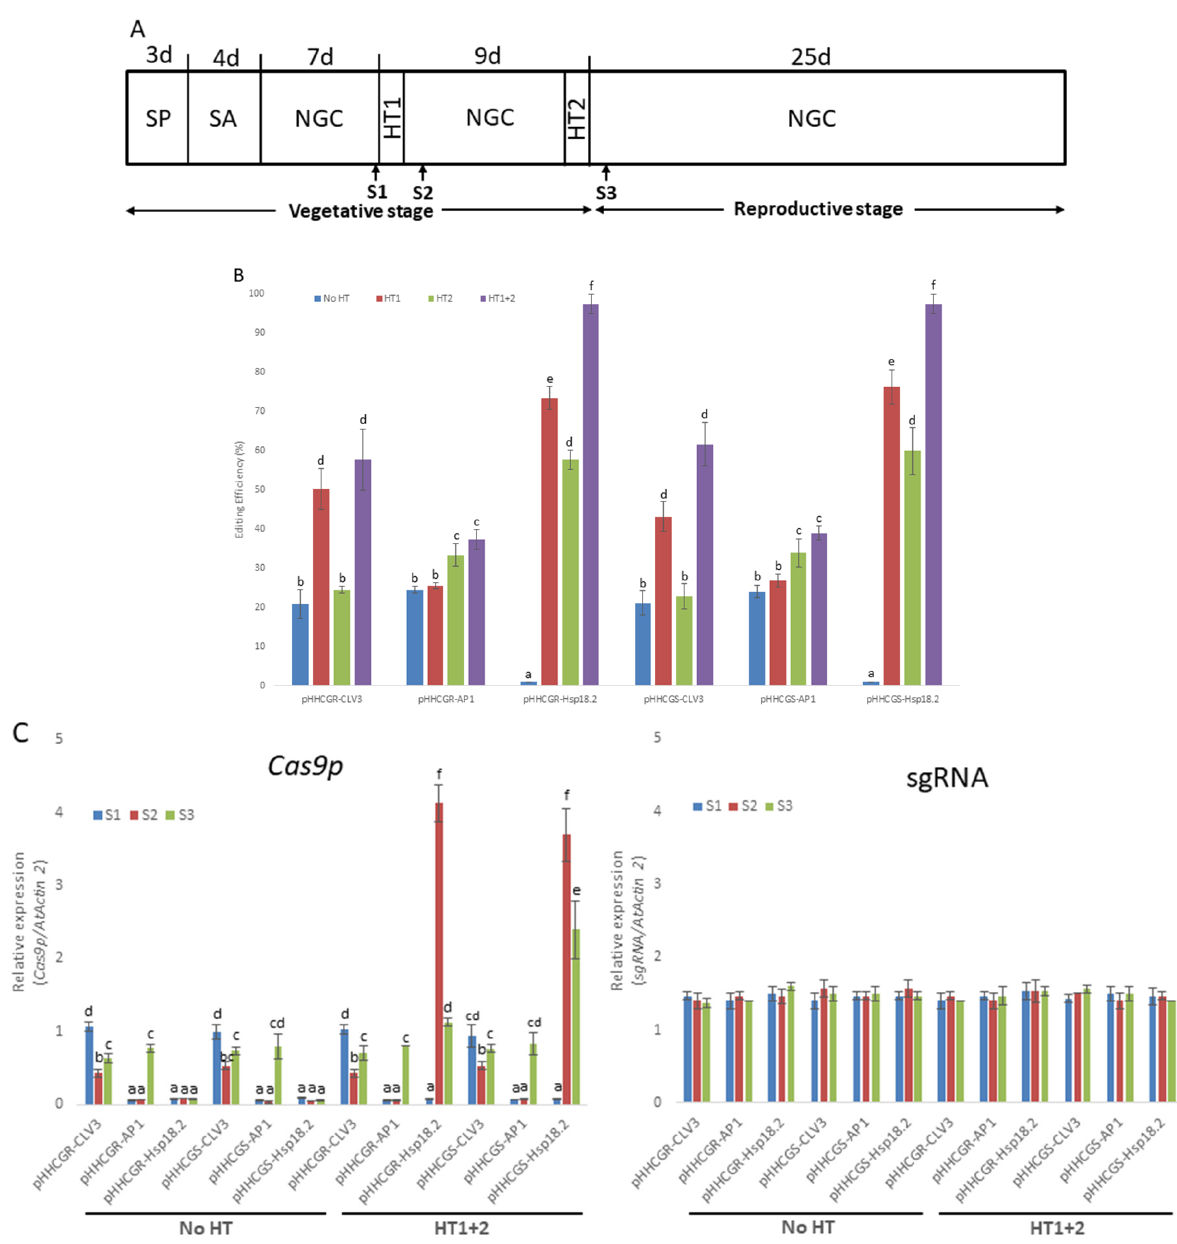
Figure 3. Heat treatments (HT) significantly increase the editing efficiency of all vectors tested in Arabidopsis thaliana (L.) Heyhn. ( A ) Schematic representation of the growth conditions of Arabidopsis plants exposed to HT. SP, plants selection on plate; SA, soil acclimation; NGC, normal growth conditions (daily 16 h light and 8 h dark, 22 ◦ C during the day and 20 ◦ C at night); HT1 and HT2, first and second HT (37 ◦ C, 30 h); S1/S2/S3, first, second and third sampling of new leaves, S2 and S3 were set at 42 h after HT; d, days. ( B ) Results overview of editing efficiency in different heat treatments and under the control of different inducible promoters. The editing efficiencies of almost all plants tested were significantly affected by different HTs. Error bars represent the range of three replicates. ( C ) RT-qPCR measurement of Cas9p and sgRNA expression with different inducible promoters and heat treatment. While sgRNA showed constant and high-level expression in all plants tested throughout the monitored period, the expression levels of Cas9p showed quite distinct variations among vectors with different IPs and HTs. Error bars represent the range of three biological replicates. Different letters above bars denote statistical